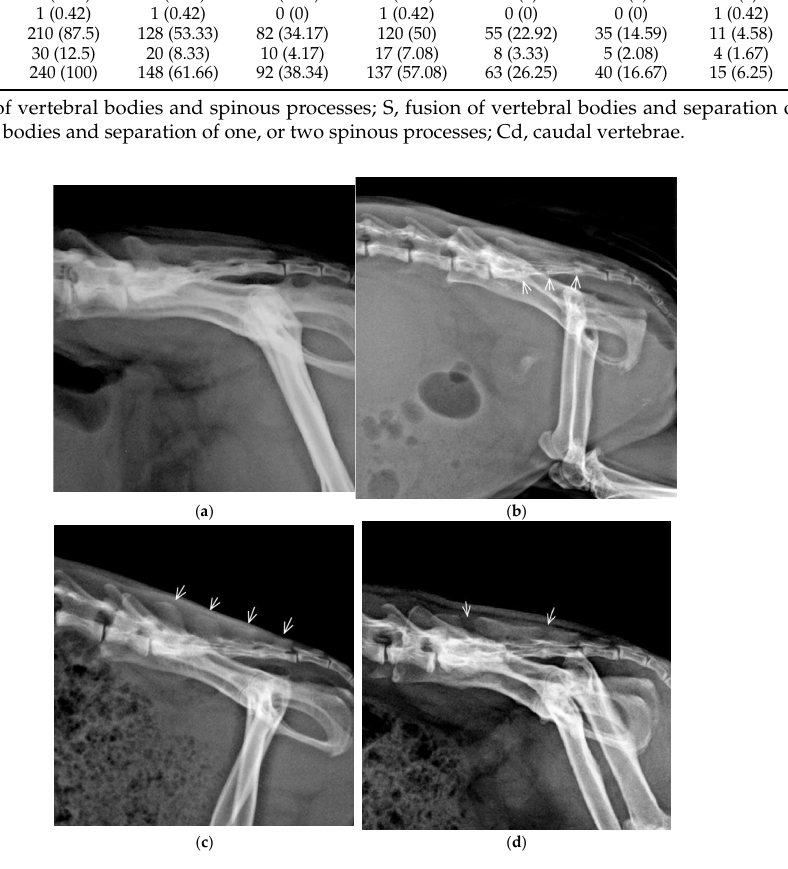
Figure 1. Lateral radiographs of the lumbosacral vertebral column demonstrating morphological variants of the sacral (S) bone-in guinea pigs: ( a ) Complete fusion of the vertebral bodies and fusion of spinous processes S1–S4 creates the median sacral crest; ( b ) Fusion of the vertebral bodies with vestigial intervertebral space (arrows) and fusion of spinous processes S1–S4 represents the most common variant; ( c ) Fusion of vertebral bodies and separation of all spinous processes (arrows); ( d ) Fusion of vertebral bodies and separation of first and fourth spinous processes.